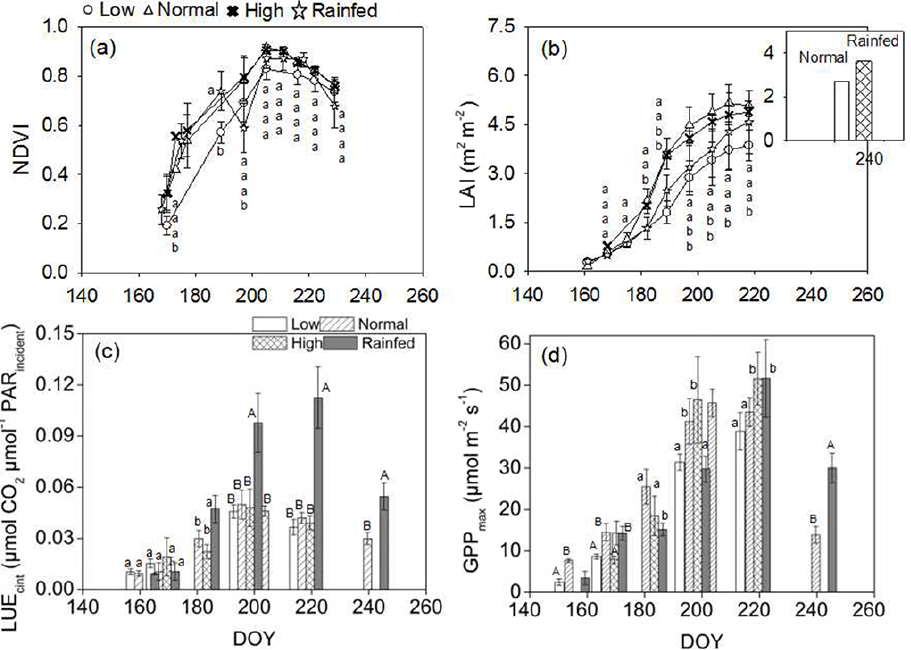
Figure 2. Seasonal courses of (a) normalized difference vegetation index (NDVI), (b) leaf area index (LAI), (c) canopy light use efficiency based on incident PAR (LUE cint ) , and (d) maximum gross primary production (GPP max ) measured at plot level in the PD low-, normal-, and high- nutrient groups, and in the RF rice. Statistic analysis showed significance at the 0.05 level (small letters) and at the 0.01 level (capital letters). Mean ± SD, n = 3 to 6. DOY: day of year. PD: paddy; RF: